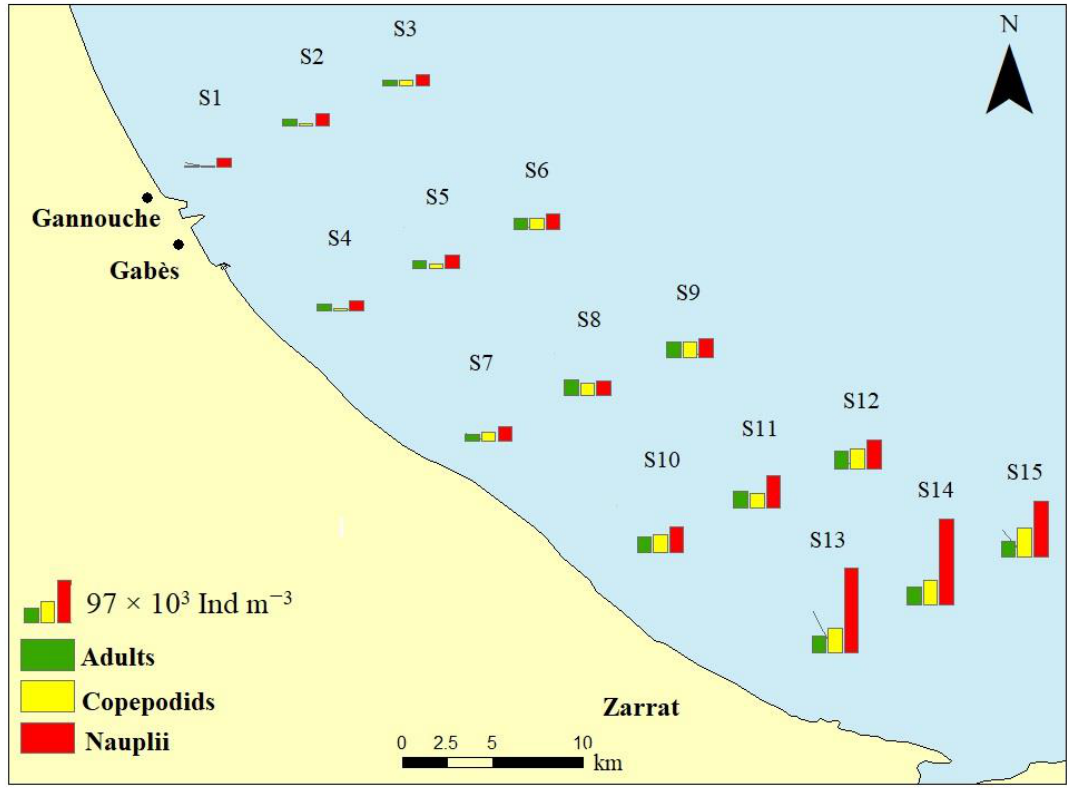
Figure 8. Spatial variations of copepod life-cycle stages’ (nauplii, copepodids, and adults) abundance: (number beside the bar indicates scale of abundance).